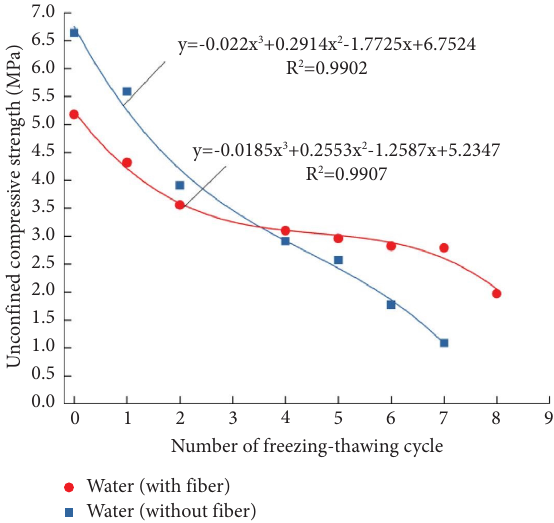
Figure 17: Relationship between strain and stress of specimens in water environment (after 5 freezing-thawing